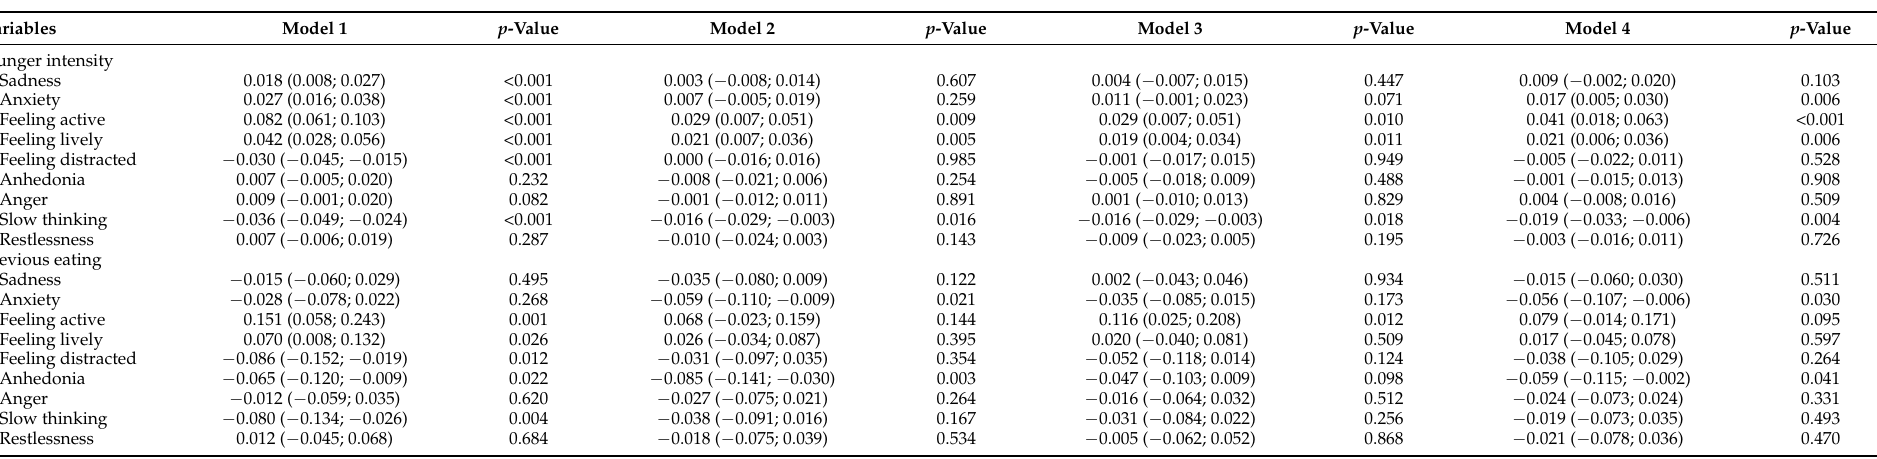
Table 2. Within-day, time-lagged associations of EMA hunger intensity and eating at time T − 1 predicting psychological states at time T, CoLaus|PsyCoLaus study, Lausanne, Switzerland, 2015–2017.